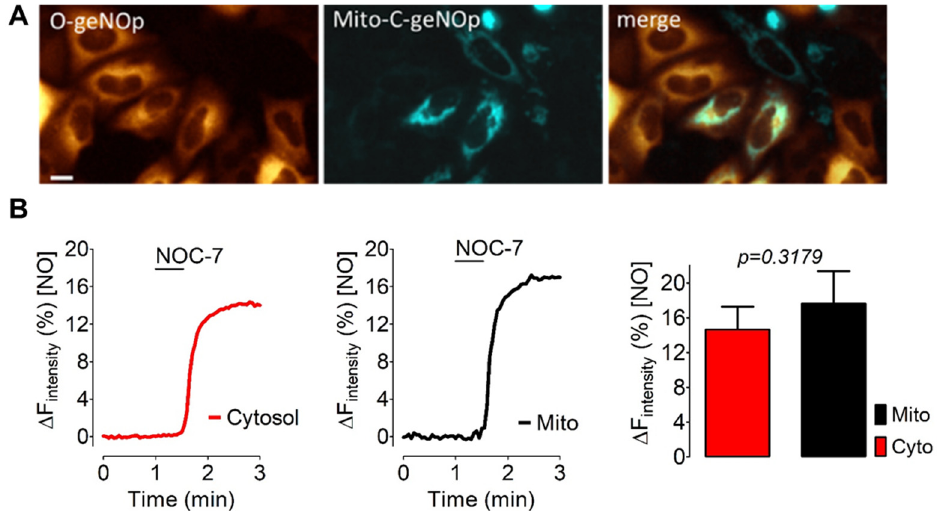
Figure 4. Assessing iron (II) levels in subcellular locales upon IS treatment. ( A ) Representative wide-field images show HeLa cells stably expressing O-geNOps-NES (orange) transiently transfected with mitochondria-targeted C-geNOps (Mito-C-geNOp, cyan). ( B ) Real-time traces of intracellular NO signals in response to 10 µM NOC-7 in the cell cytosol (red curve and bar, co-imaged with O-geNOps, n = 3/18) or mitochondria (black curve and bar, co-imaged with C-geNOps, n = 3/18). All values are given as mean ± SD, and Student’s t -test was applied to compare maximum amplitudes between mitochondria and cytosolic NO signals.